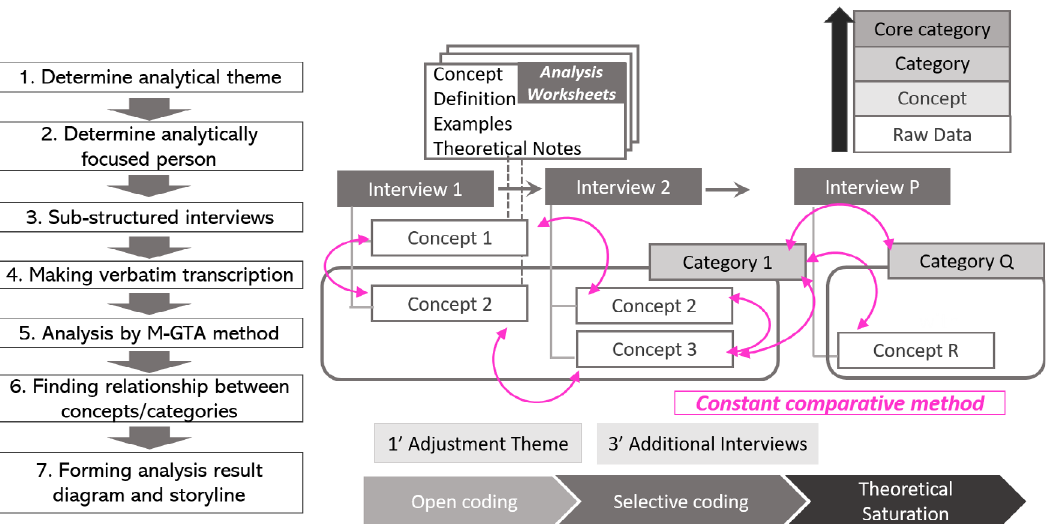
Figure 1. The procedure of the M-GTA method (modeled by the author).